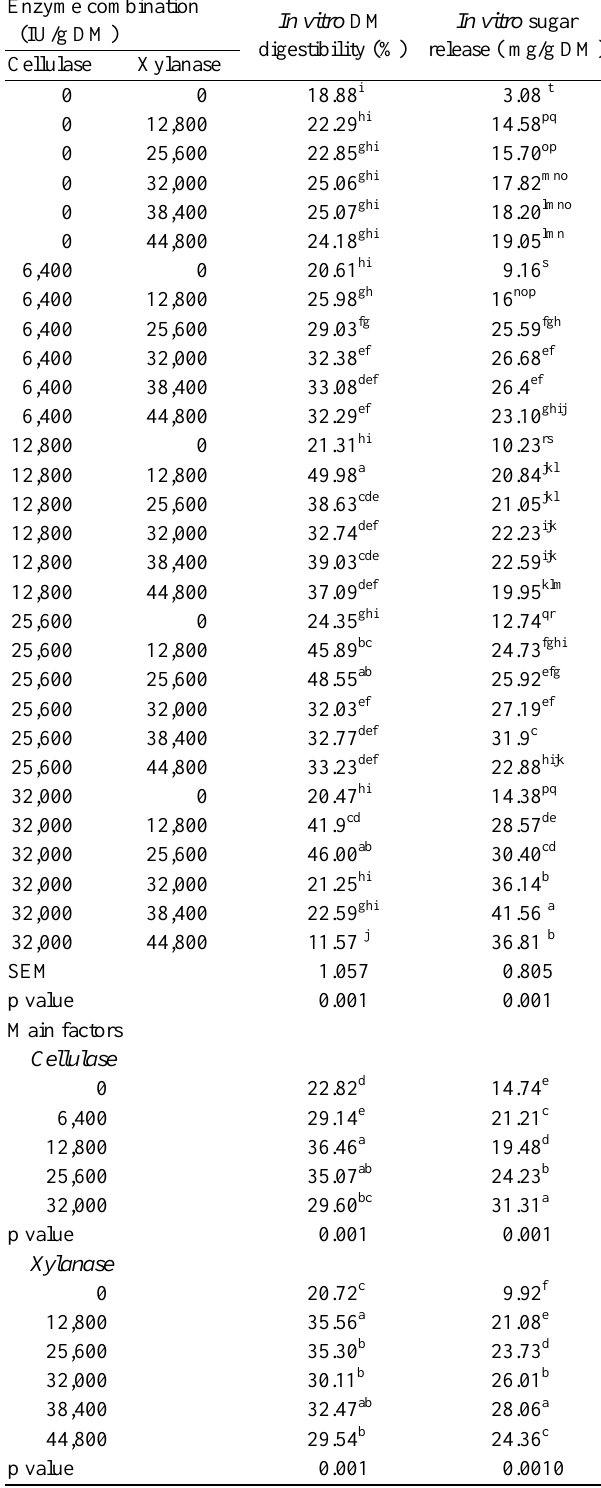
Table 2. In vitro DM digestibility (%) and total sugar release (mg/100 g DM) from maize stover supplemented with various combinations of cellulase and xylanase Enzyme